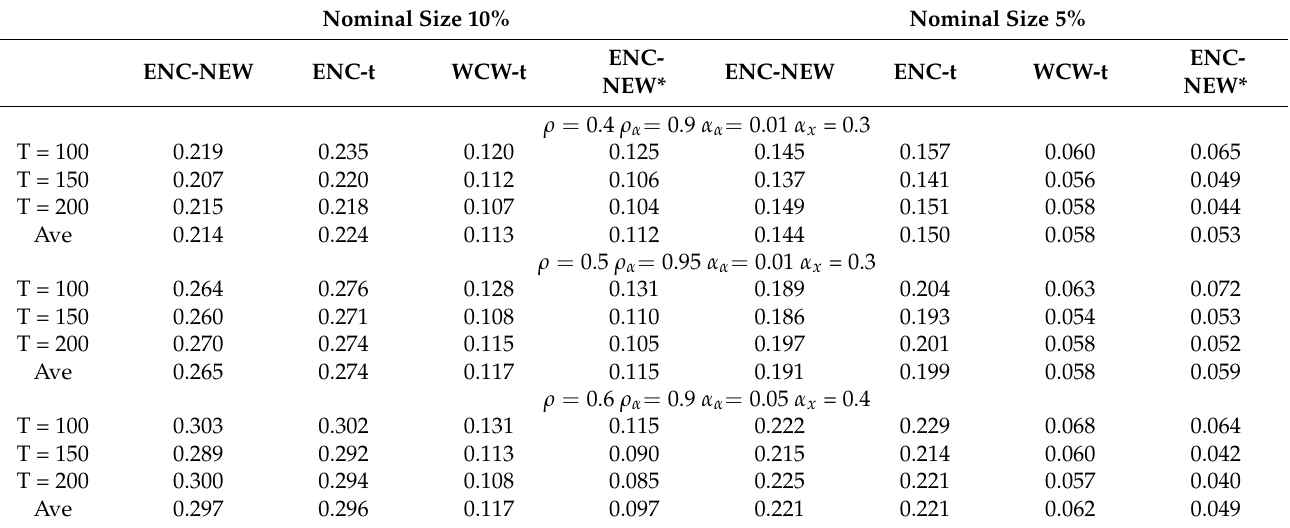
Table 6. Empirical size for P/R = 1.